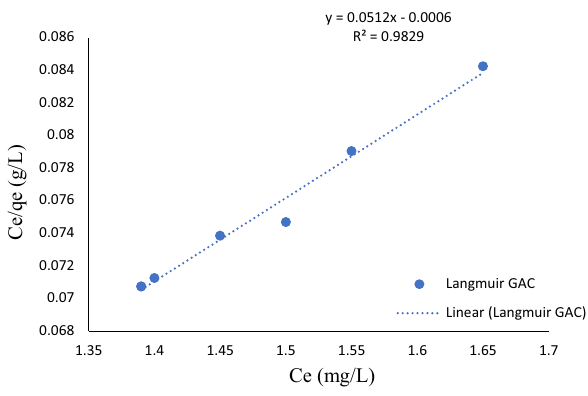
Fig. 11 Plot of C e /q e versus C e for Langmuir isotherm for GAC